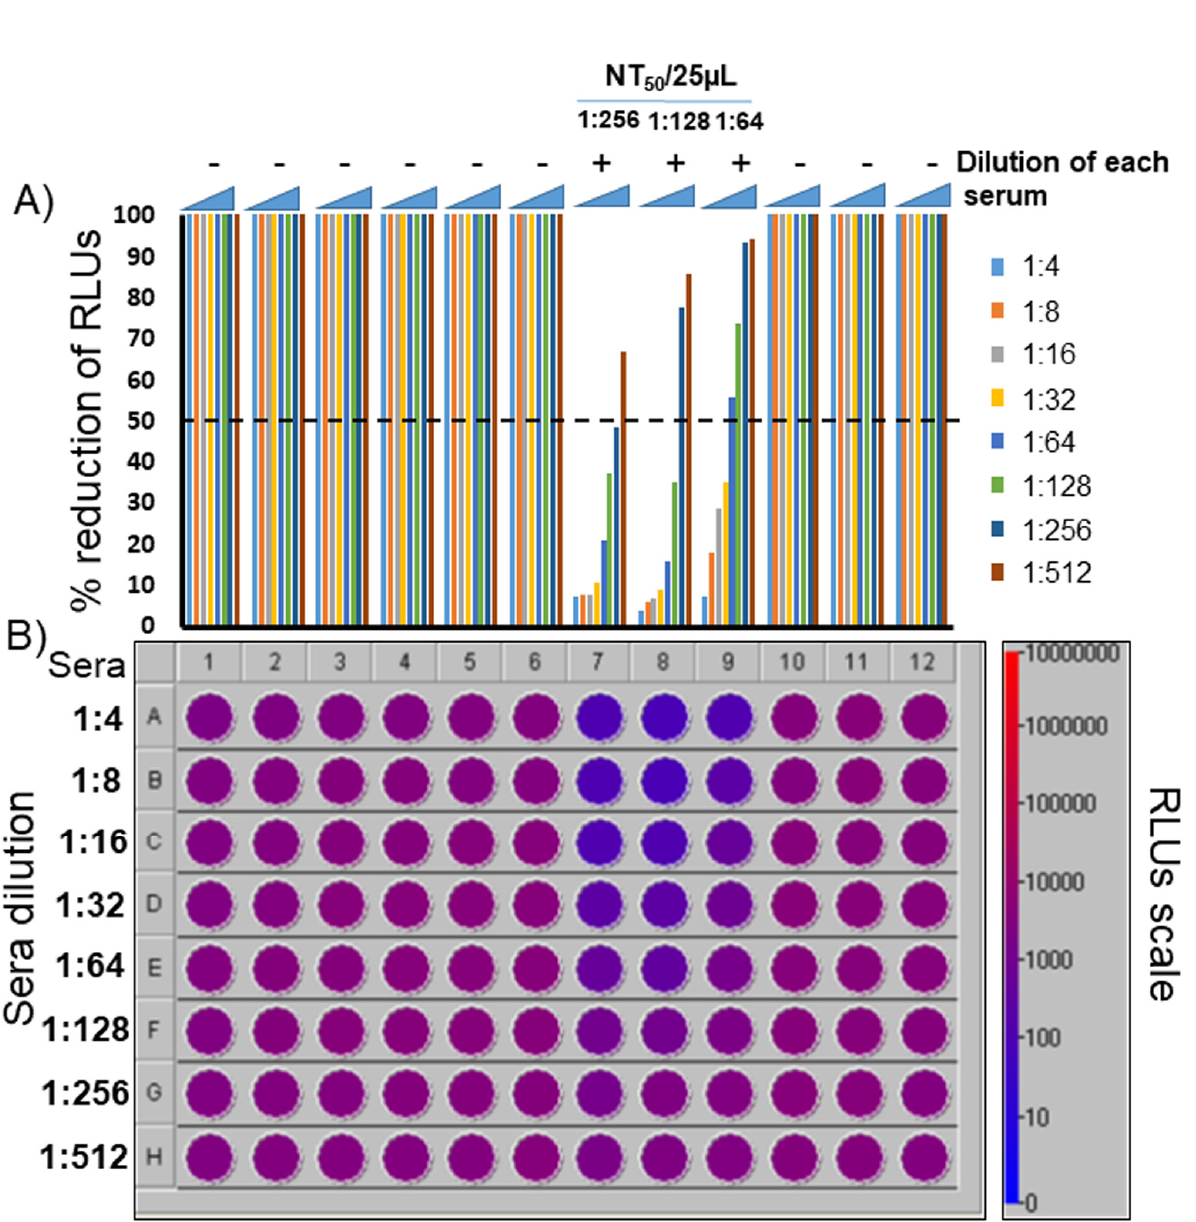
Figure 4. Representative pseudovirus neutralization assay. Six PCR and ELISA CoV-2 negative patients’ representative sera (1 to 6), three PCR and ELISA CoV-2 positive patients’ sera (7 to 9), and two pre-pandemic sera (collected in 1998; 10 and 11) were tested. A further negative control was established without serum (12), which was substituted with complete medium. ( A ) Histogram obtained from luminometric detection of transduced cells with pseudovirus. Relative luciferase units (RLUs) were compared and normalized to those derived from wells where pseudovirus was added in the absence of sera (100%). Neutralization titer 50 (NT 50 ) was expressed as the maximal dilution of the sera where the reduction of the signal was ≥ 50%. In this specific example, the NT 50 /25 μ L of serum 7 is 1:256, that of serum 8 is 1:128, and that of serum 9 is 1:64. However, because the titer was measured at 25 μ L, the apparent NT 50 has to be multiplied by 40 to obtain the normalized NT 50 /mL. Therefore, the NT 50 /mL of the sera 7 is 1:10,256, that of the serum 8 is 1:5120, and that of the serum 9 is 1:2560. Bar colors indicate sera dilution. ( B ) Colorimetric visualization of the RLUs displayed by the luminometer software, during and after reading.